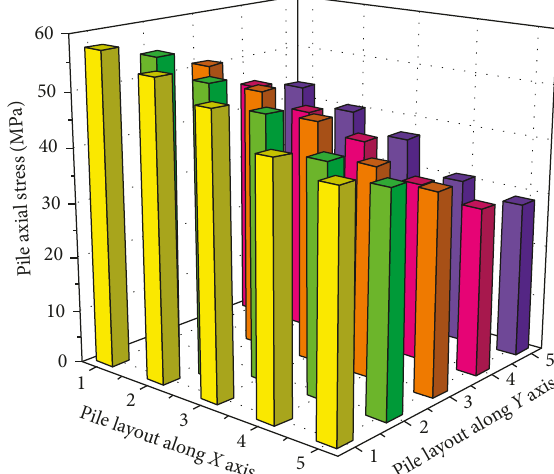
Figure 15: Settlement of piled foundation. Figure 16: Axial stress distribution of piled